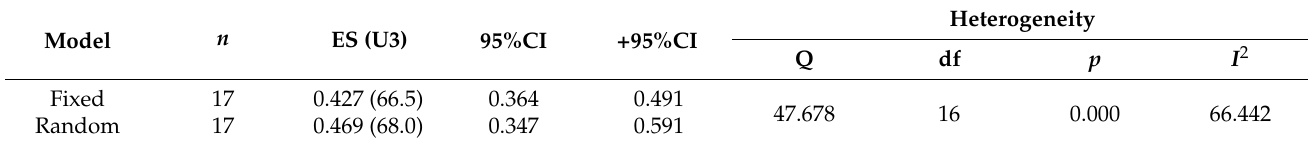
Table 4. Overall effect